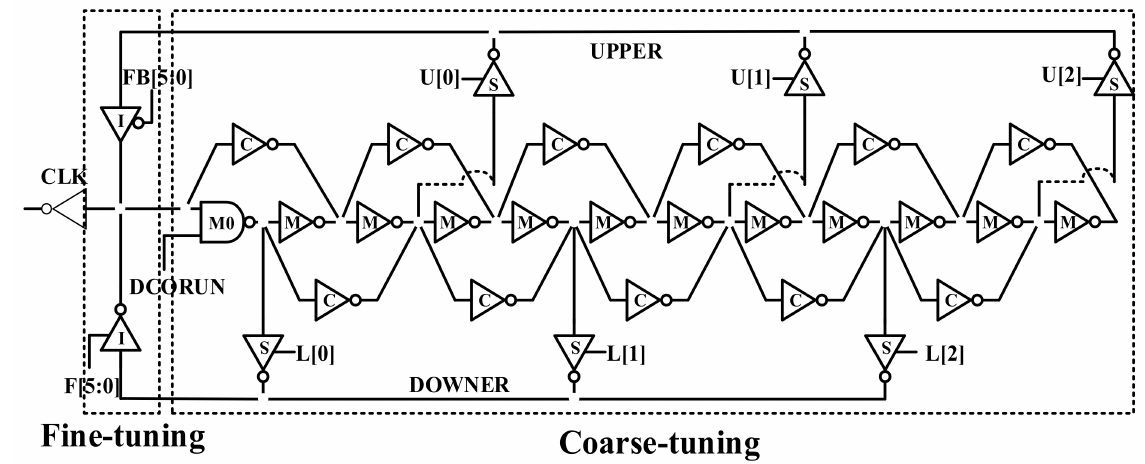
Figure 7. Schematic of the